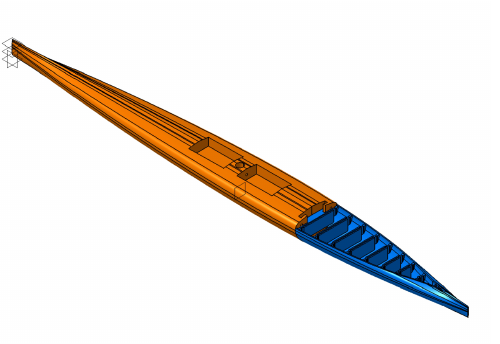
Figure 4. The draft for model C with hull in orange and stern in blue and the interlocking system for a convenient connection.